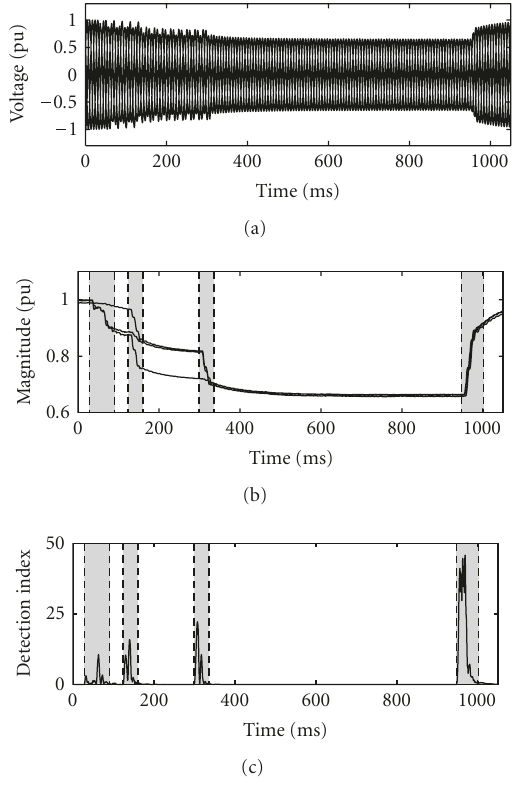
Figure 3: Using the Kalman filter to detect sudden changes ( N = 20): (a) original voltage waveforms from 3 phases; (b) the detected transition points (marked on the fundamental voltages) that are used as the boundaries of segmented blocks; (c) the detection in- dex by considering all three phases.